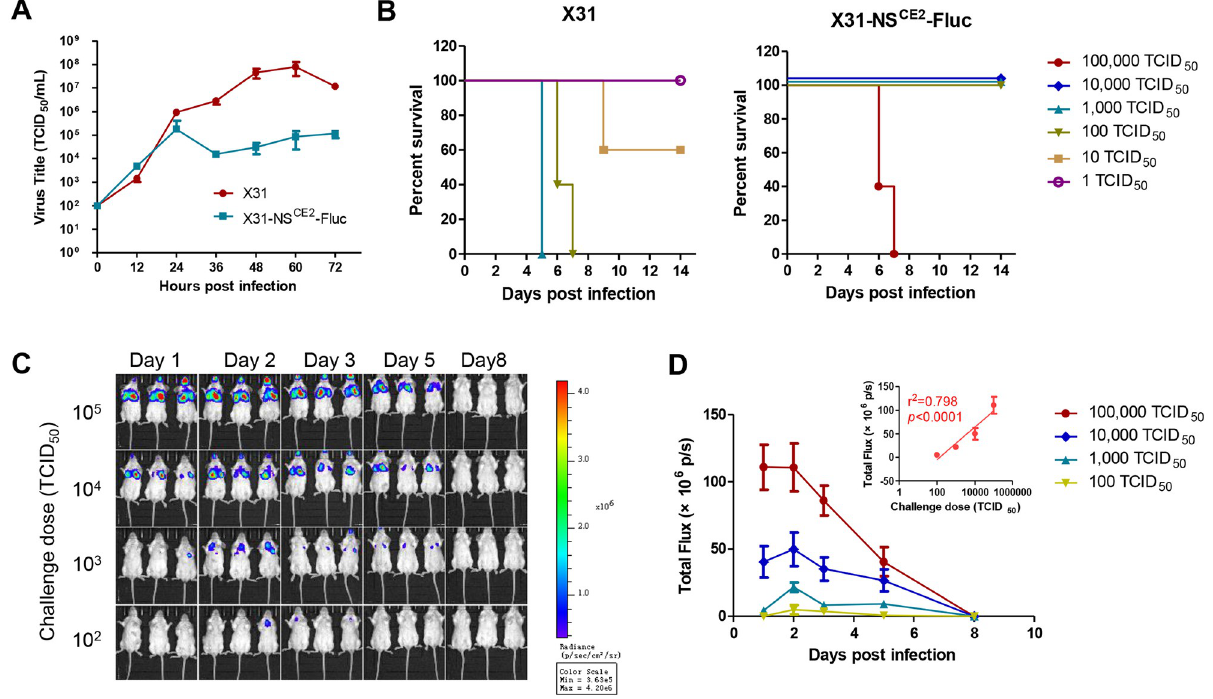
Fig 6. Establishment of an in vivo imaging mouse model of IAV subtype H3N2 infection. (A) Comparation of the in vitro replication kinetics of wildtype X31 and reporter X31-NS CE2 -Fluc viruses. (B) The lethality of wildtype X31 and reporter X31-NS CE2 -Fluc viruses in mouse models. (C) Mice were infected with series doses of X31-NS CE2 -Fluc virus and the bioluminescence was monitored at days 1, 2, 3, 5, and 8 post challenge. (D) The kinetics of bioluminescence imaging in mice infected with varies doses of X31-NS CE2 -Fluc virus. Inset, linearization analysis of the bioluminescence signals at day 2 post challenge to challenge